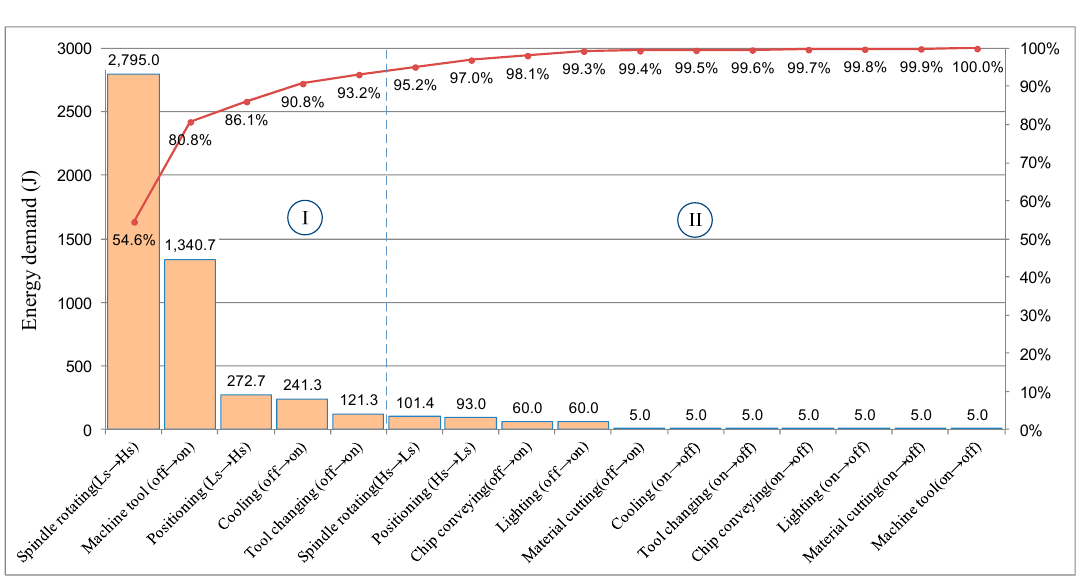
Figure 3. Pareto chart during an actual turning process.